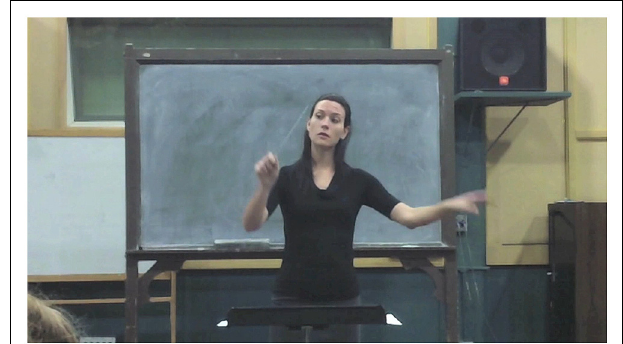
FIGURE 2 | Screenshot of conductor